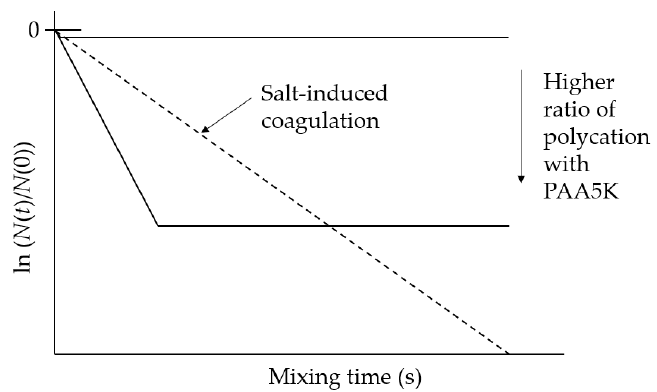
Figure 9. Schematic diagram of progressive polycation-induced flocculation in the presence of